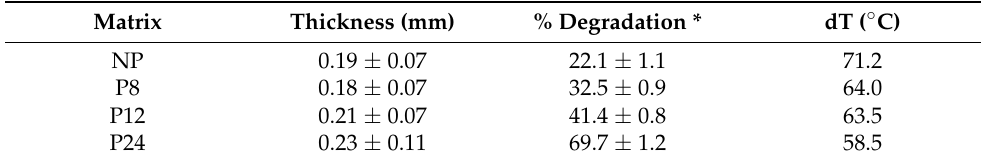
Table 1. Thickness as a function of the alkaline hydrolysis time, enzymatic degradation percentages and denaturation temperature (dT) obtained by DSC of pericardium matrices. Matrix Thickness